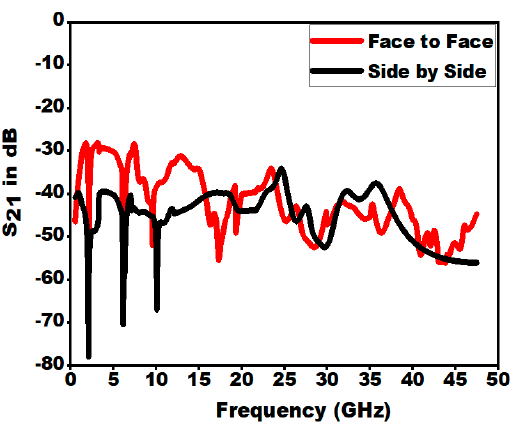
Figure 18. Transfer function (S 21 ) for the proposed triple band notch antenna for face-to-face and side-by-side